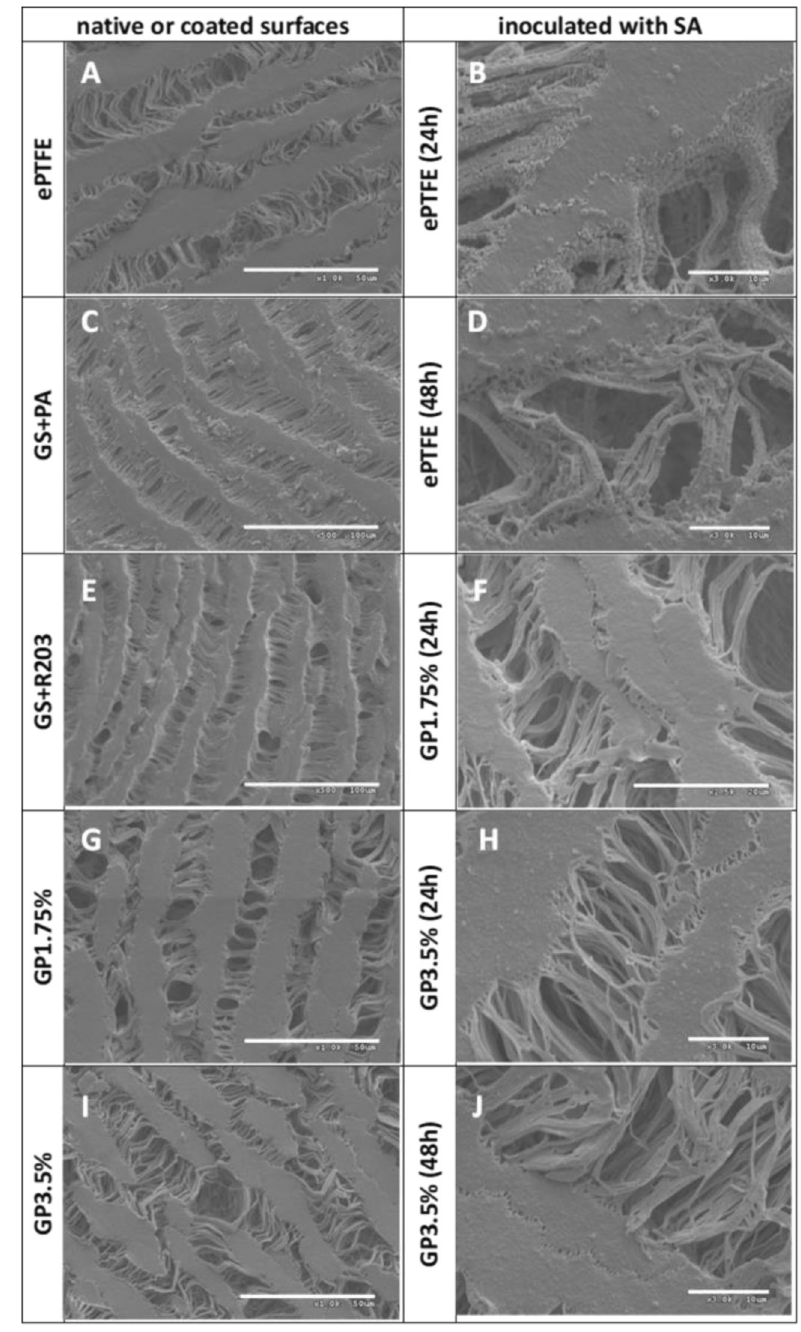
Fig. 7 SEM pictures of uncoated and various gentamicin-coated ePTFE grafts (left) and with SA incubated grafts (right) exemplarily after 24 and 48 h. A Non-coated ePTFE graft (×1000); B , D ePTFE graft (×3000) after SA inoculation time; C , E , G , I diverse coated surfaces for GS + PA, GS + R203 and GP variants; F , H , J show GP coating variants after 24 and 48 h of SA exposure at 37 °C indicating highly reduced numbers of adhered SA compared to uncoated ePTFE graft ( B + D